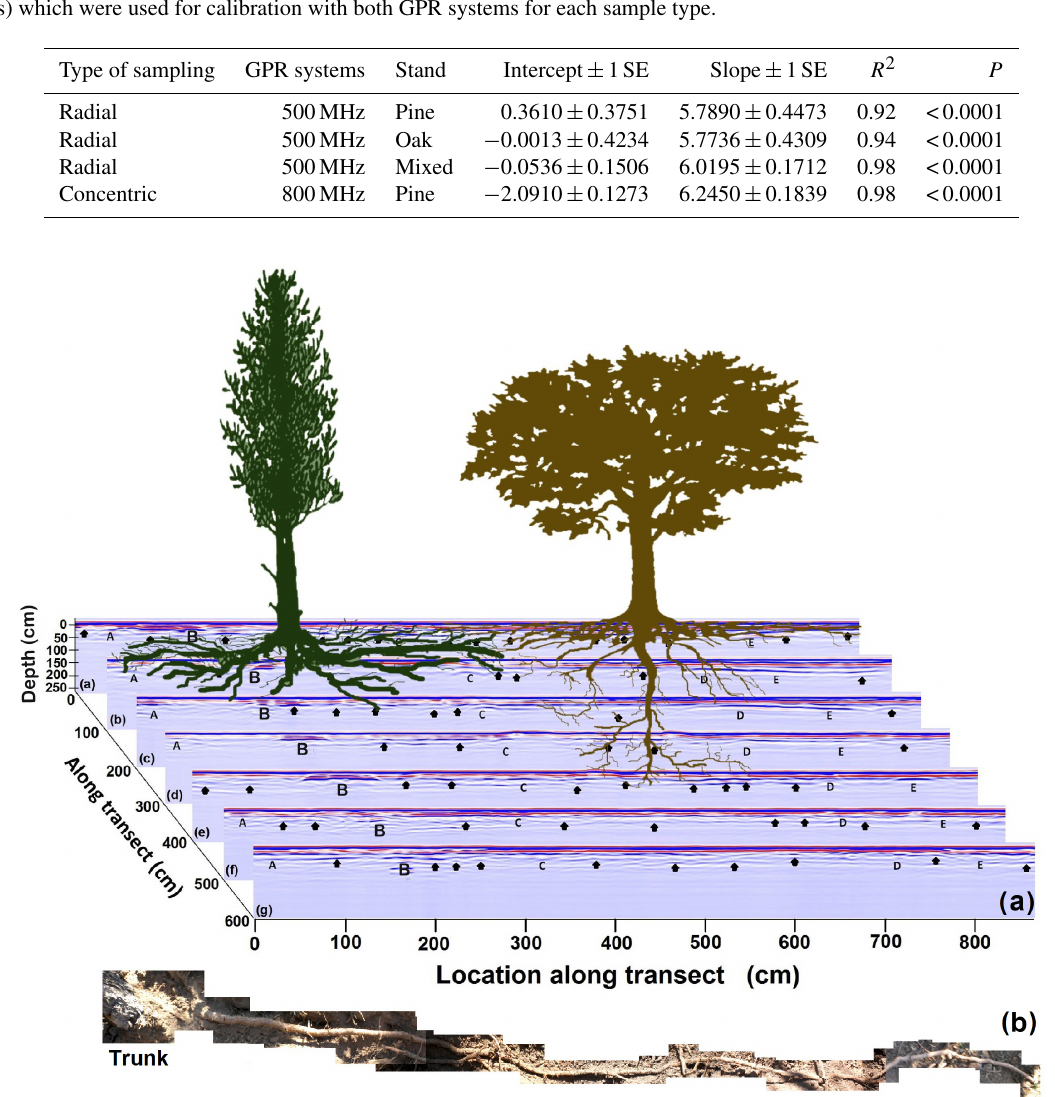
Figure 3. Mapping of root systems with GPR showing the potential for radargrams to represent an approximation of horizontal root distri- bution. (a) Two-dimensional radargram sequence obtained with the 500MHz shielded antenna performing seven parallel transects of 8.5m, spaced 1m apart. In each radargram, cross sections of roots were identified and then their diameters estimated. By linking root reflectors in neighboring GPR radargrams, the orientation and length of each single root were obtained (same letters). Arrows and letters in different GPR radargrams correspond to reflections from the same roots; these were used for calibration in situ. With the 500MHz shielded antenna, the position, size and depth of roots with 2.5 to 7.5cm diameter were estimated. The image shows an example of the position of a pine and oak tree and the potential application of the GPR tool for spatially explicit root distribution studies. (b) Horizontal elongation of a root axis of Pinus cembroides marked with the letter “B” in panel (a)